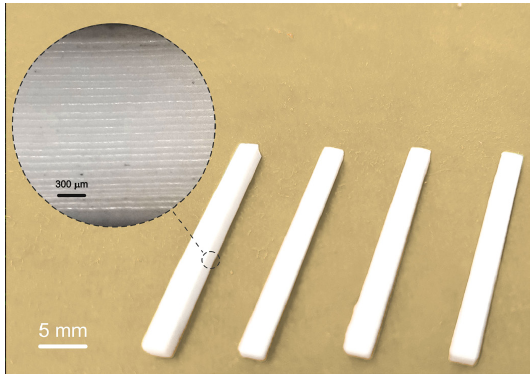
Figure 9. Sintered printed bars with magnified view of the